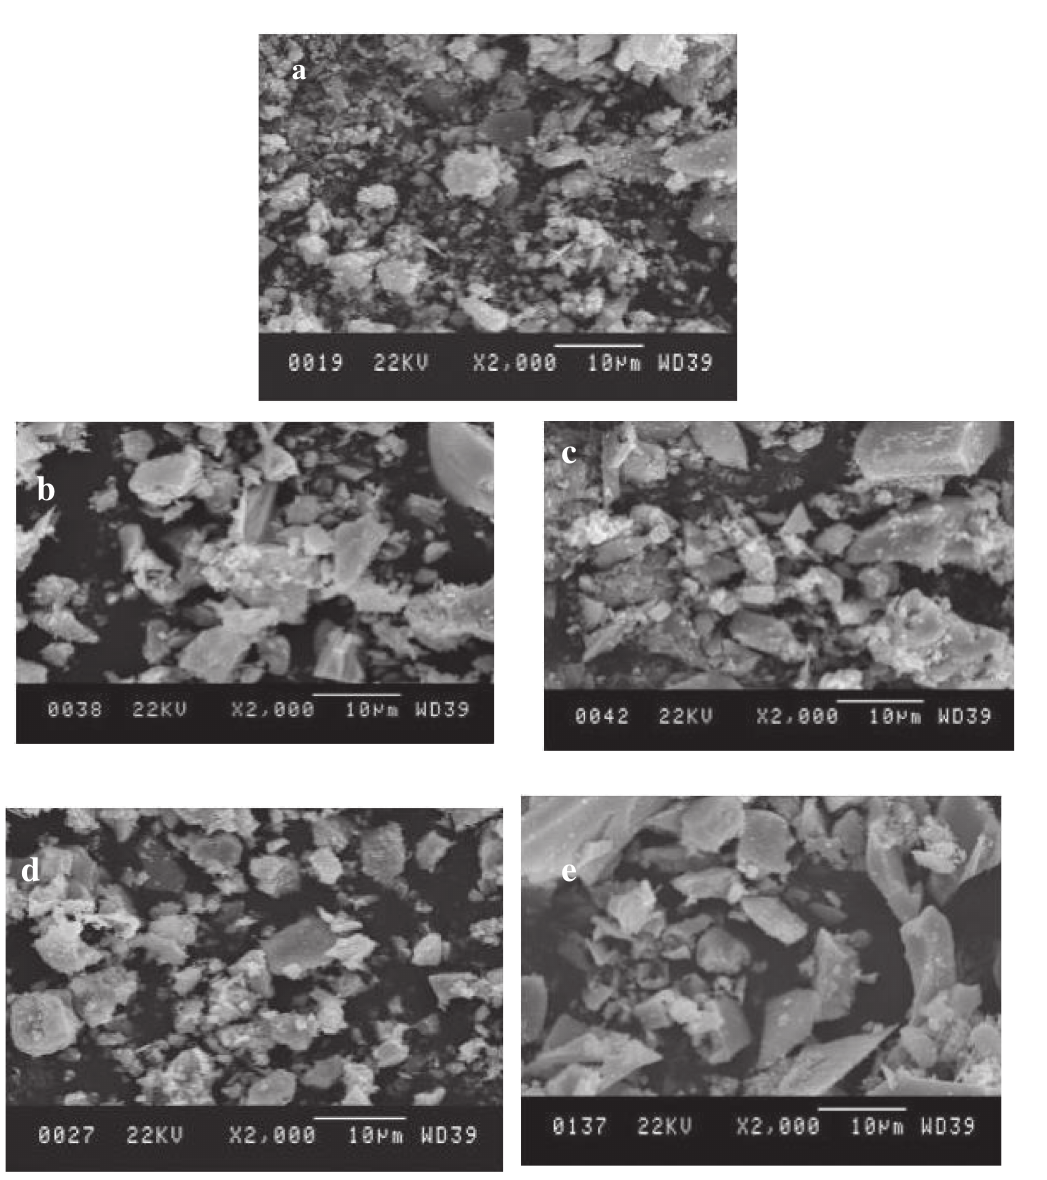
Figure 9: SEM of Co 3 O 4 powder at different doping levels of manganese (a) undoped, (b) 3%Mn, (c) 5%Mn, (d) 7%Mn and (e) 9%